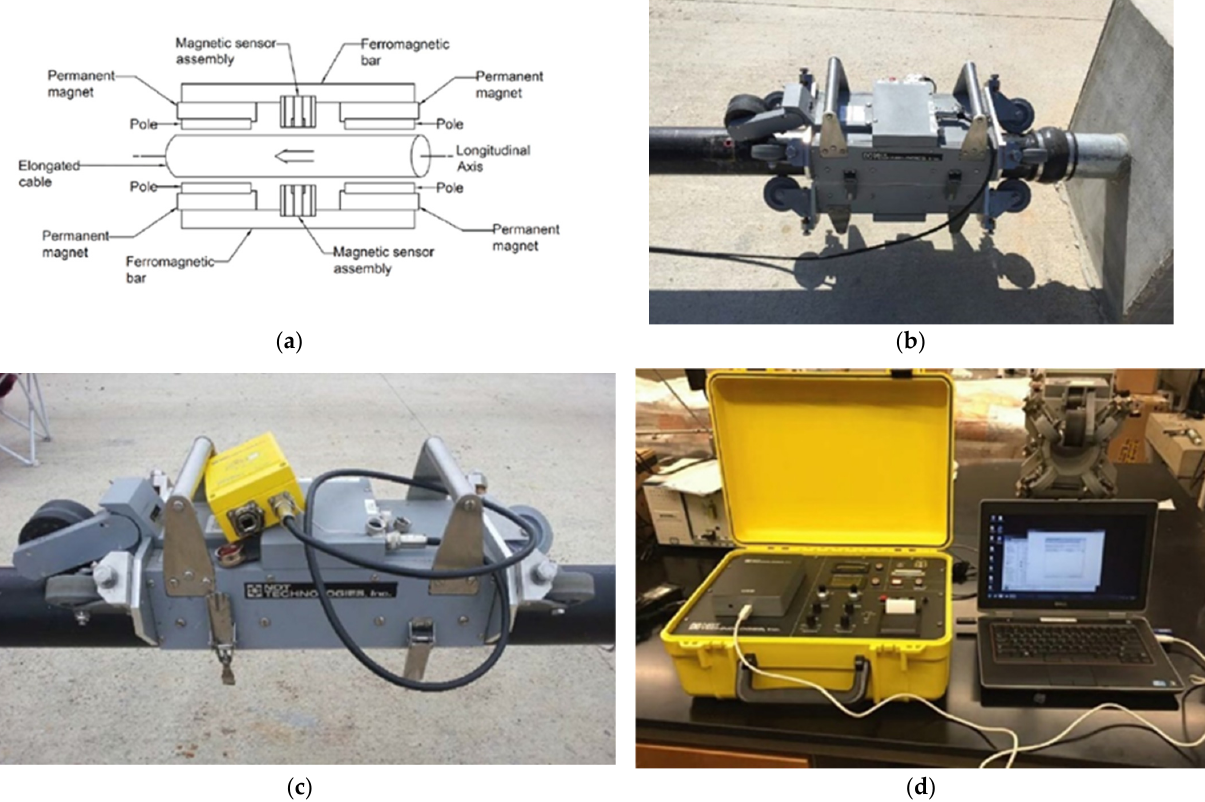
Figure 7. Magnetic flux leakage ( a ) sensor probe, ( b ) full head sensor, ( c ) half head sensor, ( d ) the connection of the NDE extension to the computer [9].